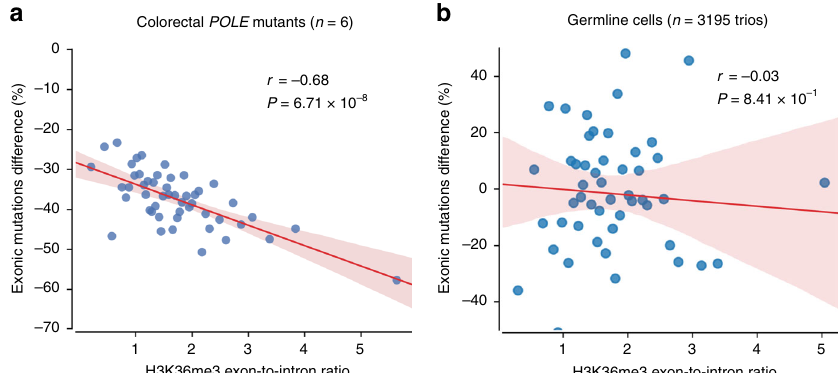
Fig. 4 Deviation in the exonic mutation burden as a function of the H3K36me3 exon-to-intron ratio. Blue dots denote 50 groups of genes binned by their exon-to-intron ratio of H3K36me3 coverage ( x -axis). The relative difference between the total observed and expected number of exonic mutations (computed using a 3-mer model) per group is shown on the y -axis. The trend line and its con fi dence interval were added using the seaborn package of Python, while the correlation coef fi cient and its signi fi cance were computed using the same iteratively re-weighted least-squares approach as used